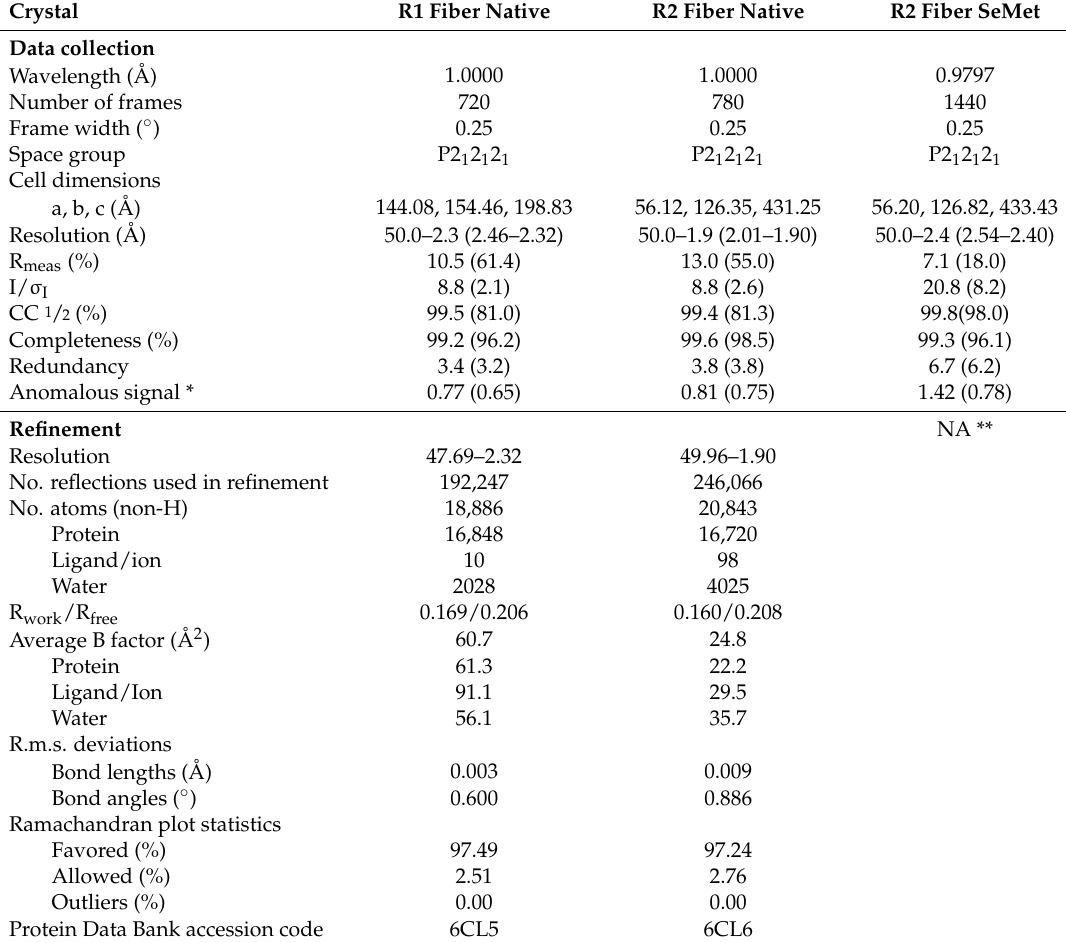
Table 1. X-ray data collection, reduction, and refinement statistics for R2 and R1 pyocin fiber